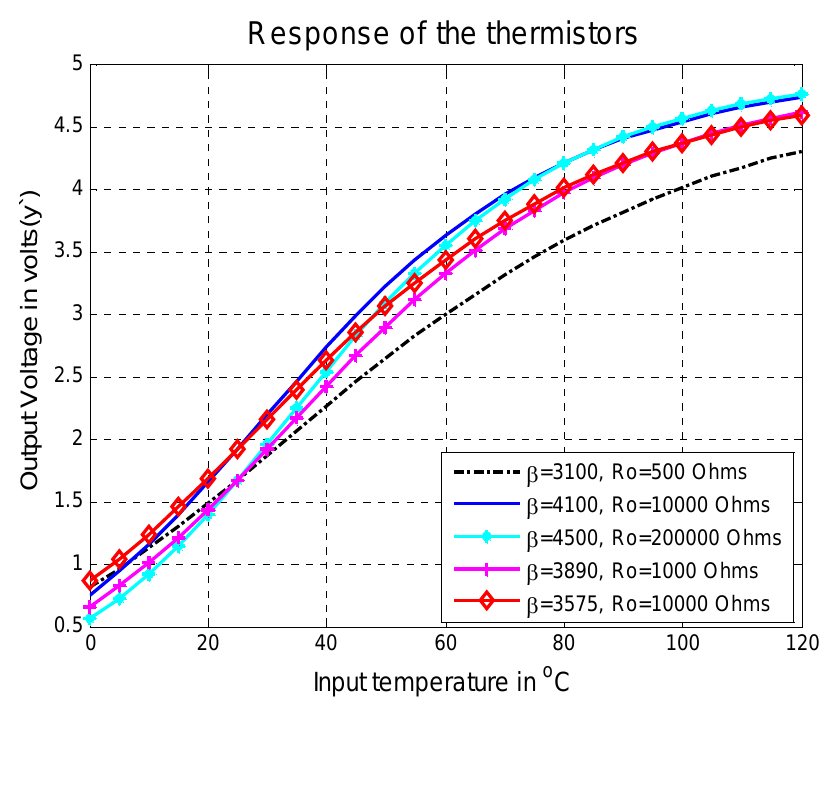
Figure 9. Response of thermistors used in the temperature measurement system (Ro is the resistance of the thermistor at 25 o